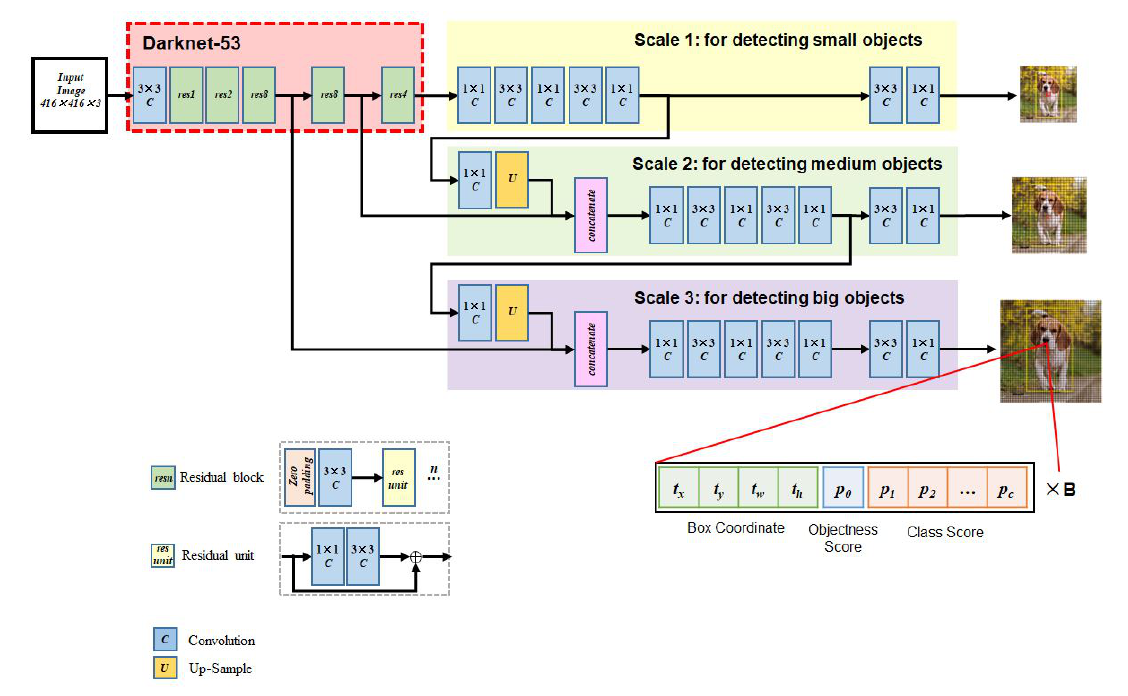
Figure 4. Architecture of YOLOv3 Model to Detect PPE(s) in